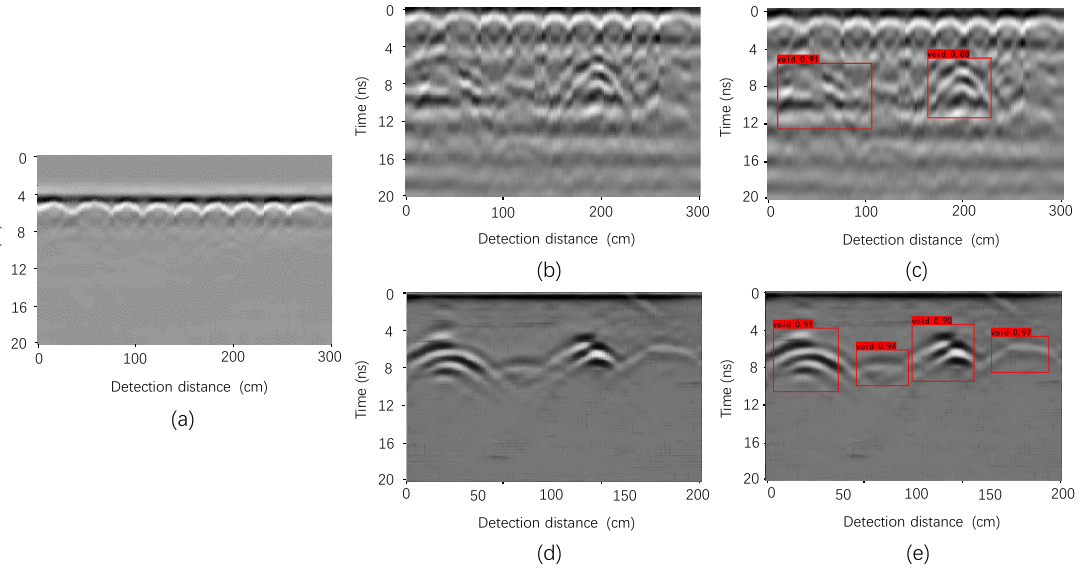
Figure 12. Results of the real-world experiment. ( a ) raw GPR image; ( b ) processed GPR image; ( c ) voids detected by YOLOv4 from the processed GPR image; ( d ) rebar clutter elimination using the RCE-GAN; ( e ) voids detected by YOLOv4 from the rebar clutter eliminated GPR